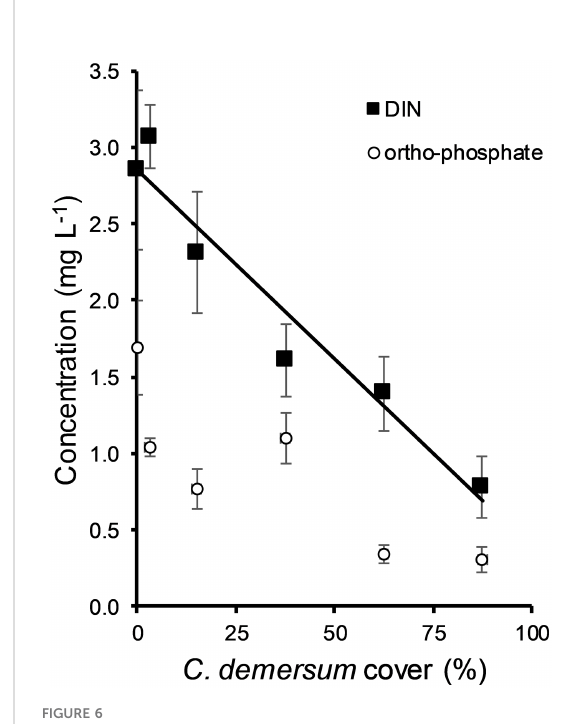
FIGURE 6 Correlation between the coverage of Ceratophyllum demersum and concentrations of dissolved inorganic nitrogen (DIN) and ortho-phosphate (means ± standard error) in Hungarian water bodies. Data were collected from the database of Hungarian surface waters (n =